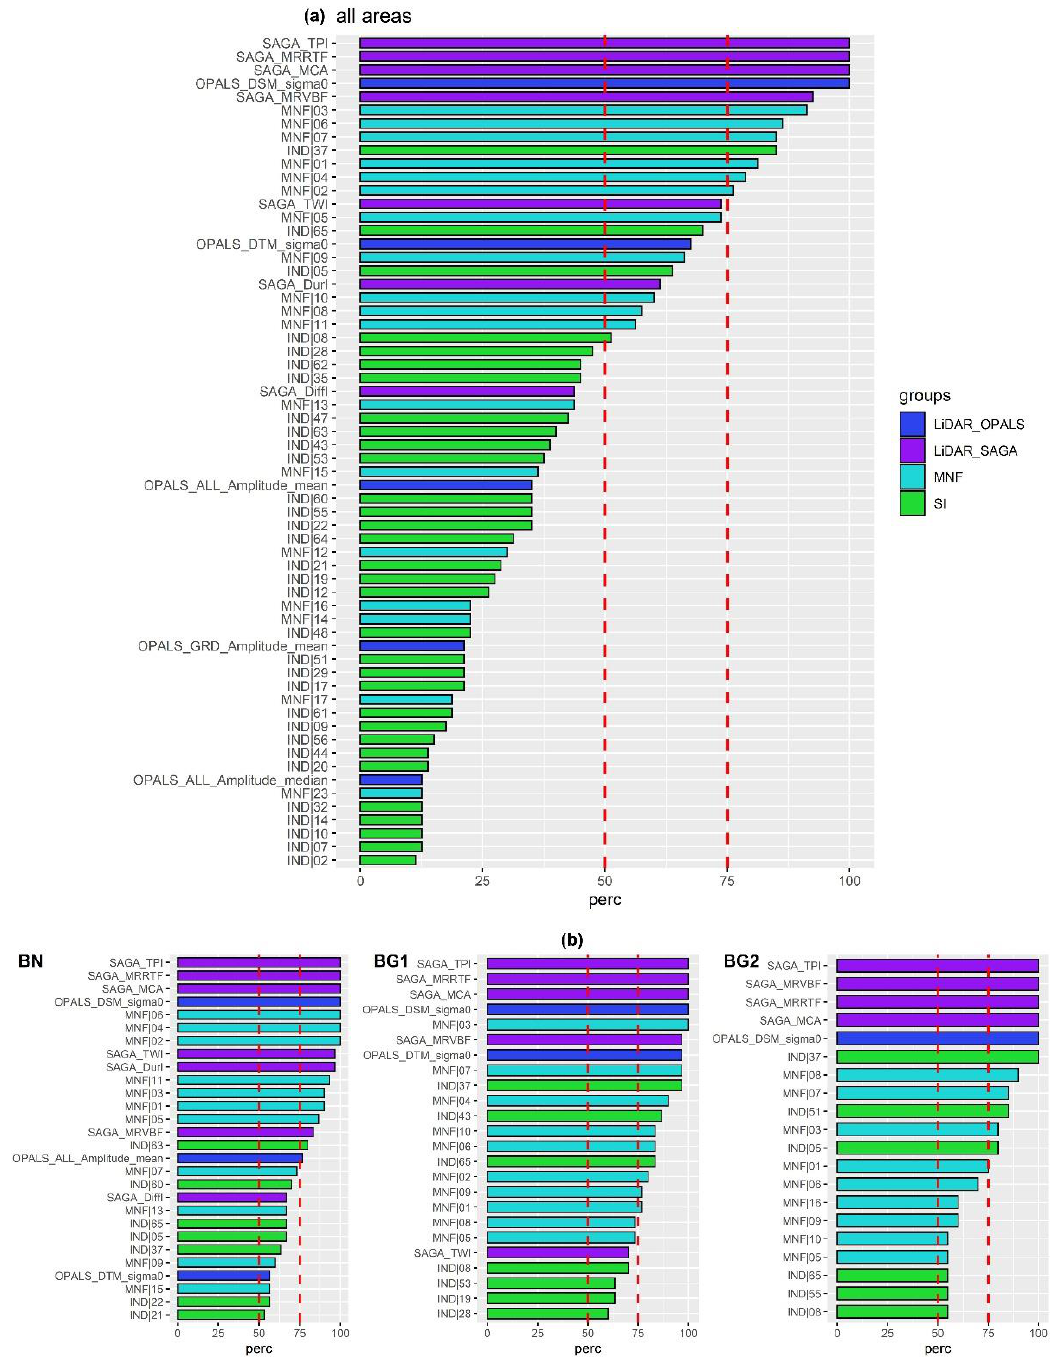
Figure 10 . Frequency distribution of mostly selected input features when considering all study areas together ( a ) or considering area by area ( b ) (only features being selected more than 10% times are